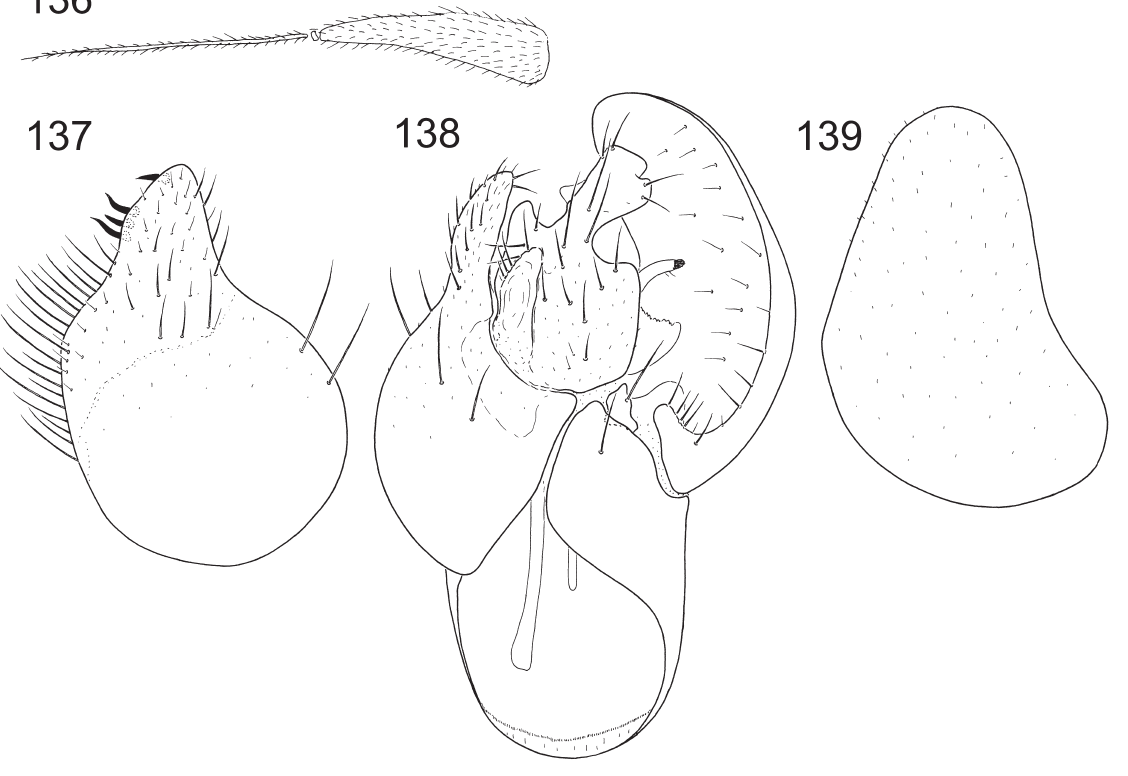
Figs 136-139. Elaphropeza chanae sp. nov., ♂. 136 . postpedicel and stylus of antenna, lateral view. 137 . right epandrial lamella, lateral view. 138 . epandrium with cerci, dorsal view. 139 . left surstylus, lateral